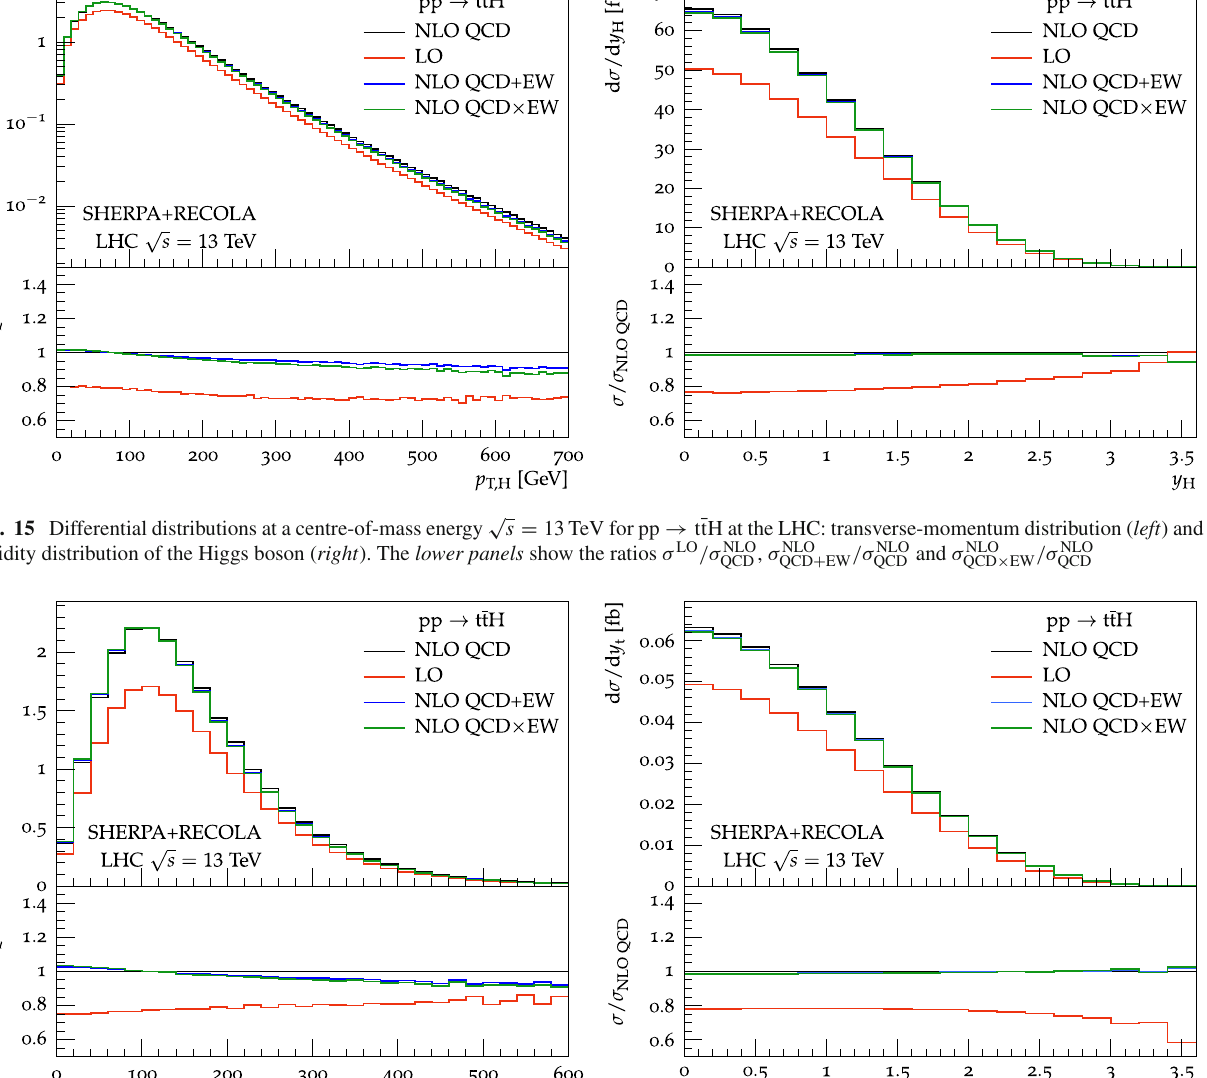
Fig. 16 Differential distributions at a centre-of-mass energy rapidity distribution of the top quark ( right ). The lower panels show the ratios σ LO /σ NLO